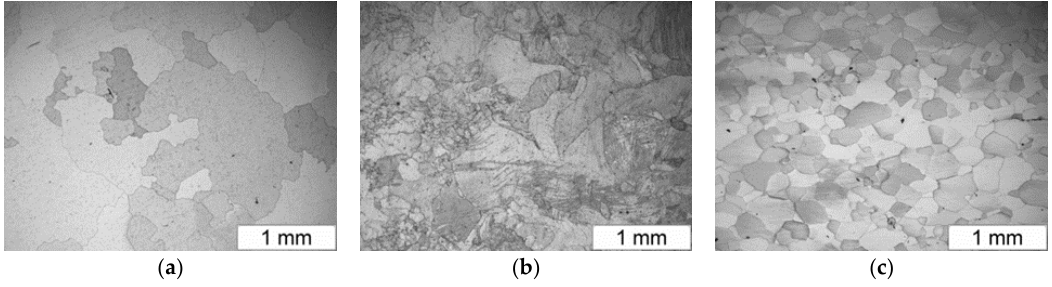
Figure 1. The microstructure of the Fe40Al5Cr0.2TiB alloy: ( a ) after casting, ( b ) after hot extrusion, ( c ) after hot rolling.